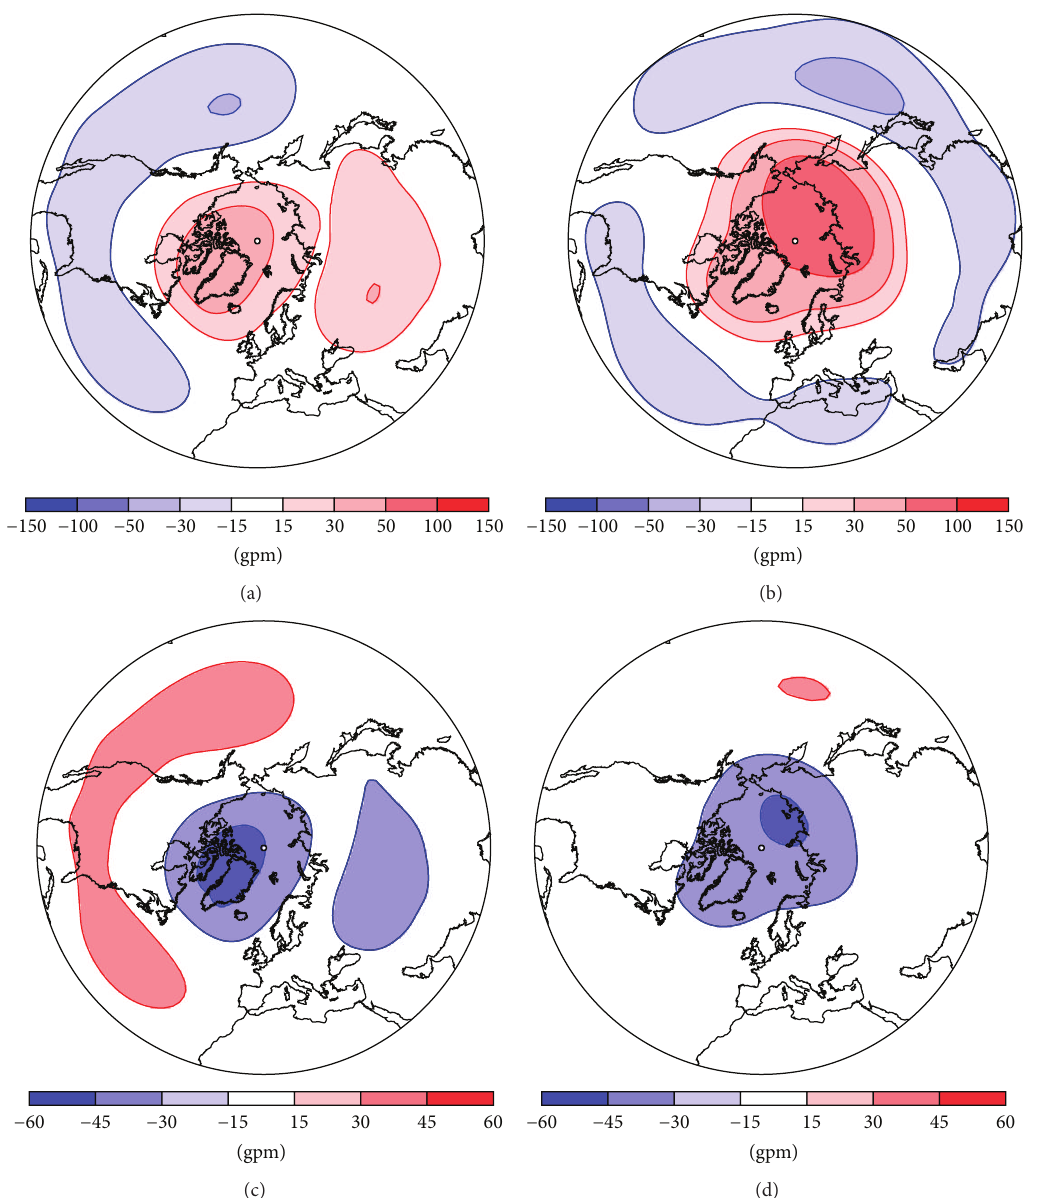
Figure 14: Composite geopotential height (gpm) anomaly patterns of the modeled regimes of experiment I (areas A–D in Figure 13 left) at the 833 hPa